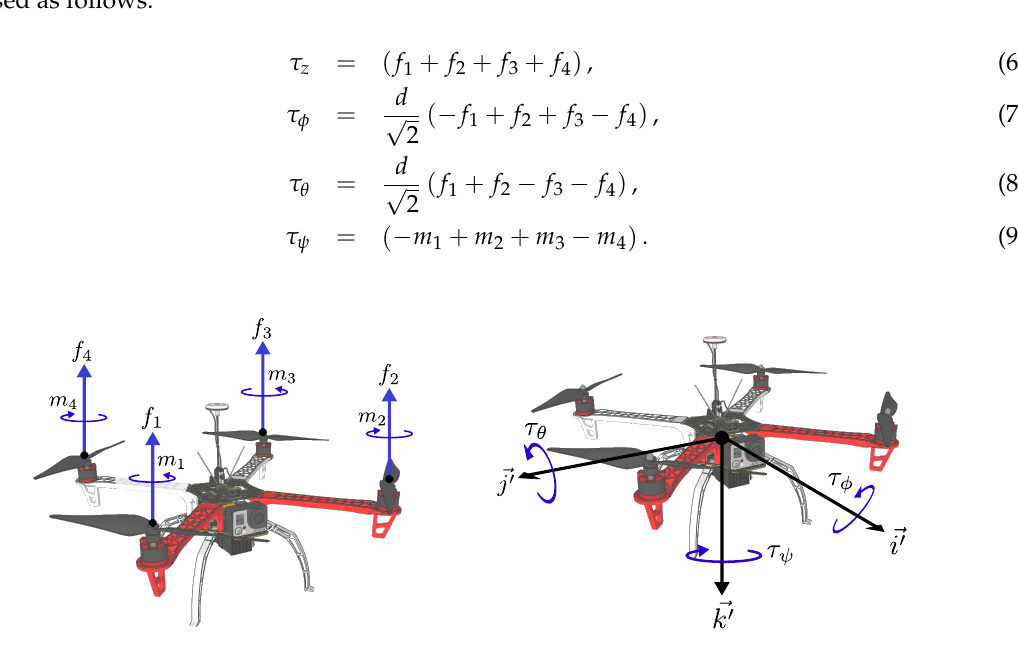
Figure 3. Quadrotor orientation, yaw ( ψ ), pitch ( θ ) and roll ( φ )